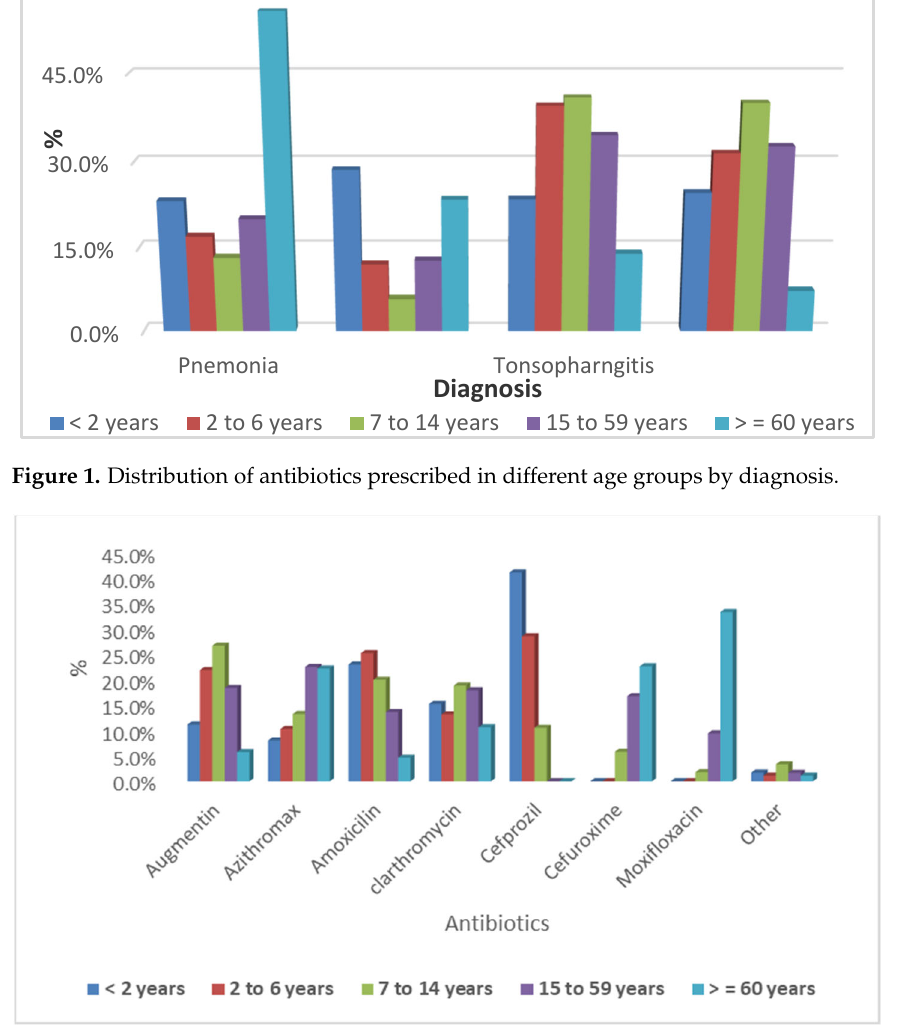
Table 2. Outcome of treatment for respiratory tract infections.